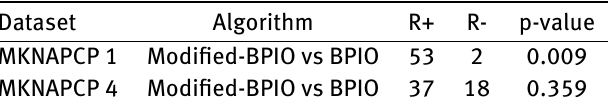
Table 10: Wilcoxon Signed Ranks Test